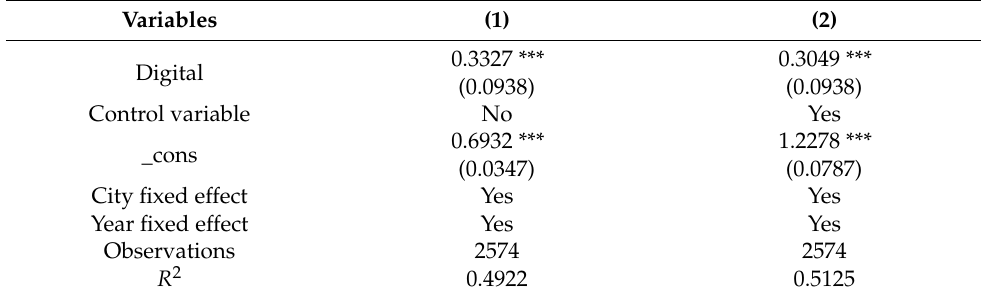
Table 6. Two-way fixed effect regression results.